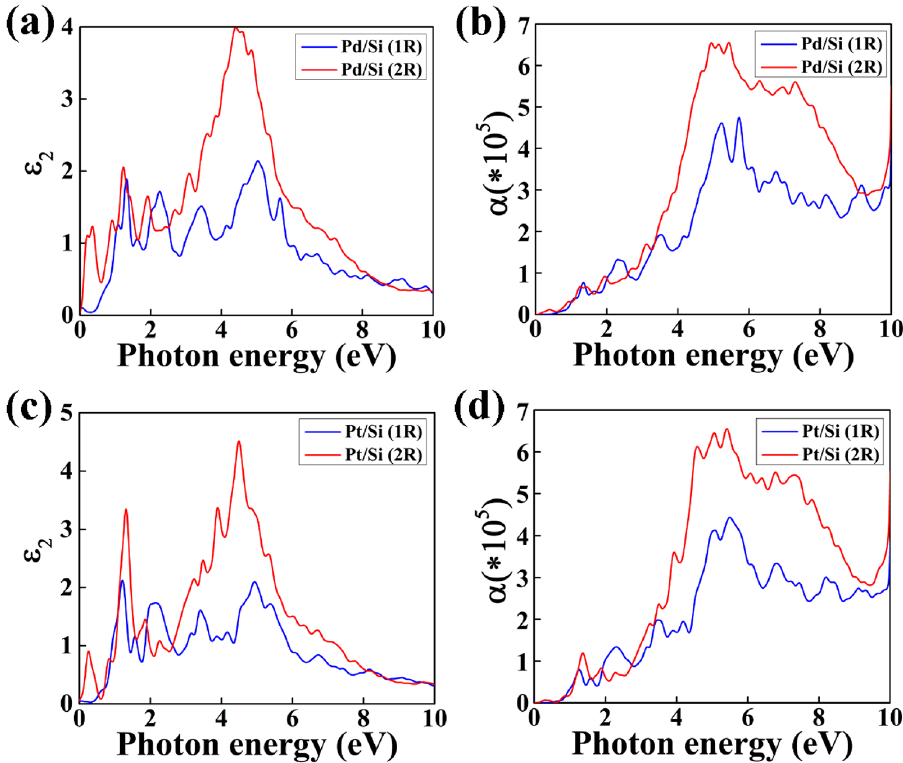
Figure 6. The diameter dependent imaginary part of the dielectric constant ( Ɛ 2 ) with photon energy and its corresponding adsorption co-efficient are shown in ( a , b ) for Pd/Si and ( c , d ) for Pt/Si core/shell